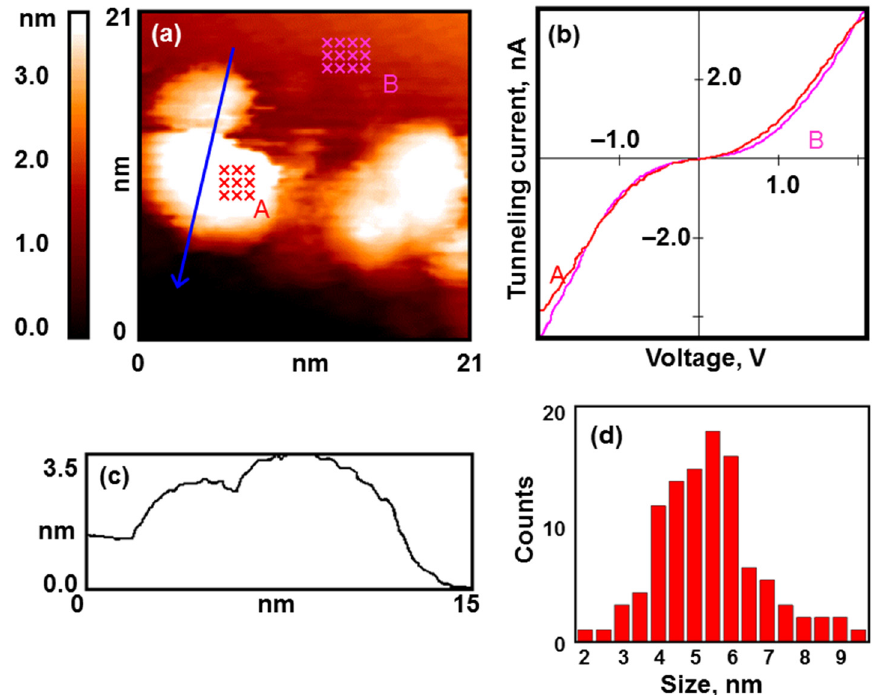
Figure 1. Nanoparticles of gold after calcination under UHV conditions. Results of the STM/STS measurement: ( a ) topography image of the HOPG surface with deposited gold nanoparticles; ( b ) VAC curves of the tunneling currents averaged over the set of points on the surface of the nanoparticles (red curve A) and HOPG (pink curve B) marked with crosses in ( a ); ( c ) profile of the surface along the cut line shown in ( a ); ( d ) size distribution.